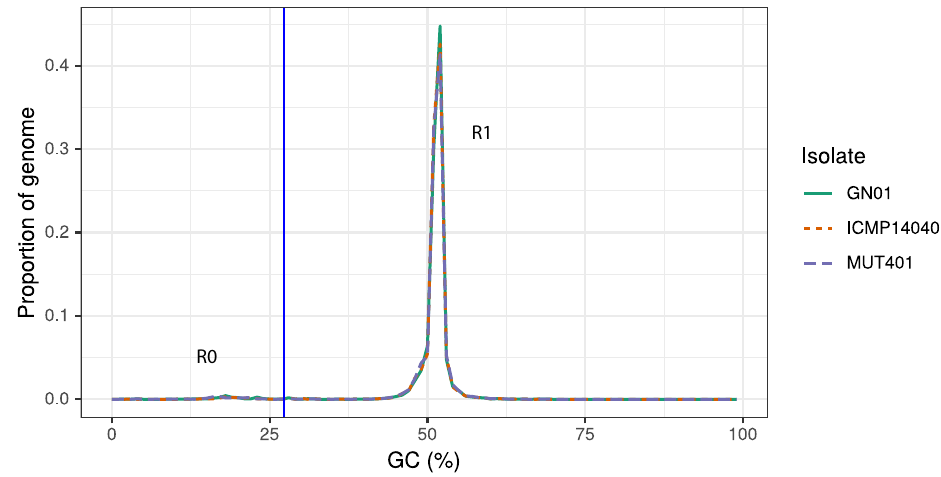
Figure 5. Bimodal distribution of the GC content in the three genomes identified identified by Occultercut as enriched in AT (R0) and GC equilibrated (R1) using a GC content threshold indicated by the vertical blue line.